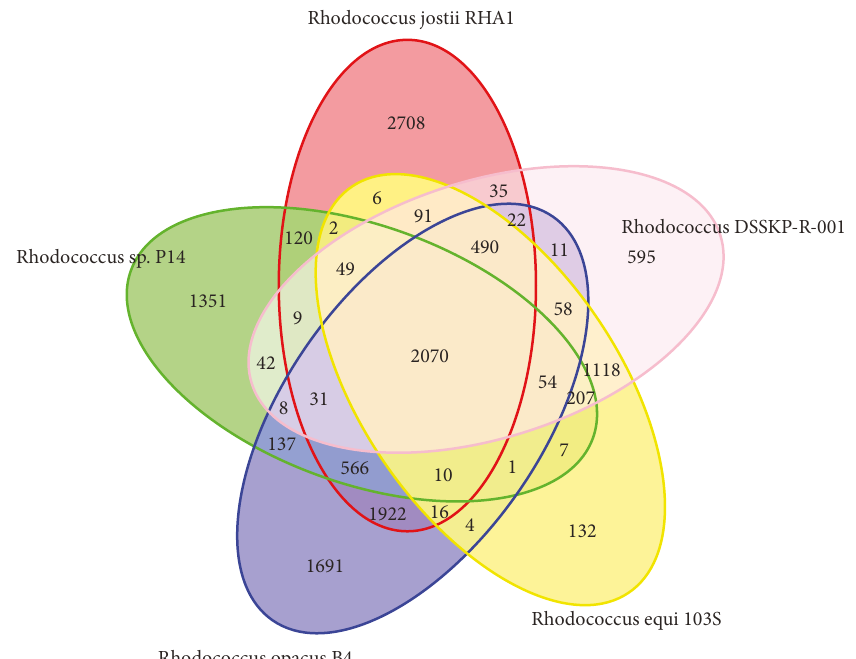
Figure 9: Number of Core/Pan genes in the genome Venn chart. Description: each ellipse represents a sample, the data on each area represents the number of groups that appear only in the sample in this area, and each group represents a group with a greater than 50% similarity, with a sequence length di ff erence of less than 0.7 gene